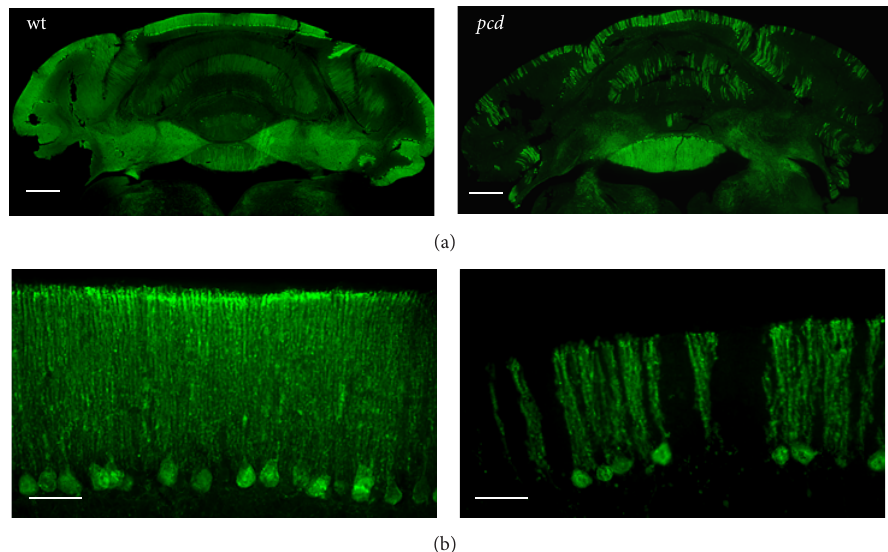
Figure 1: Labelling of calbindin expressing PC neurons in wt and pcd mice. Purkinje cells and their axons in the cerebellum show a strong immunoreactivity for calbindin. In one month old wt anti-calbindin antibodies detect the Purkinje cells and their axon in the cerebellum. The neurons of the cerebellum in one-month-old pcd mice reveal less calbindin immunoreactivity. Scale bar: 100 𝜇 m (a) and 50 𝜇 m (b). wt